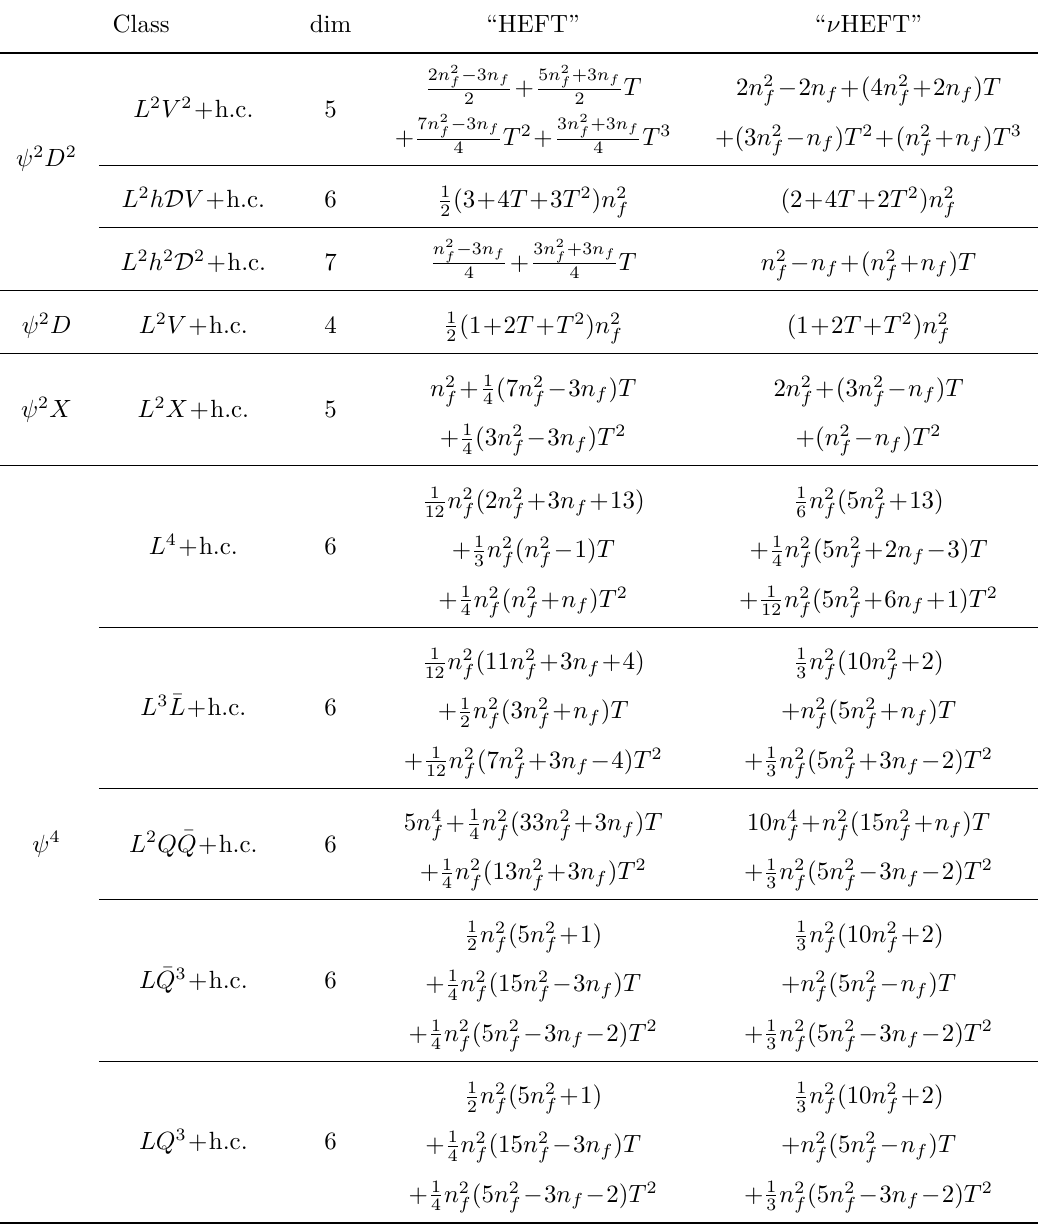
Table 8 . Spurion structure of the detailed breakdown of the eight classes of operators that are relevant for “NLO” ( ν )HEFT, fermionic sector violating B and/or L . We emphasize that apart from the last row, LQ 3 + h.c., which preserves B − L , this table is not providing the correct result